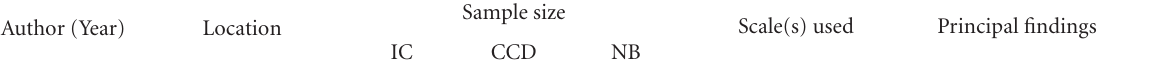
Table 2: Quality of life in patients treated with continent and incontinent urinary